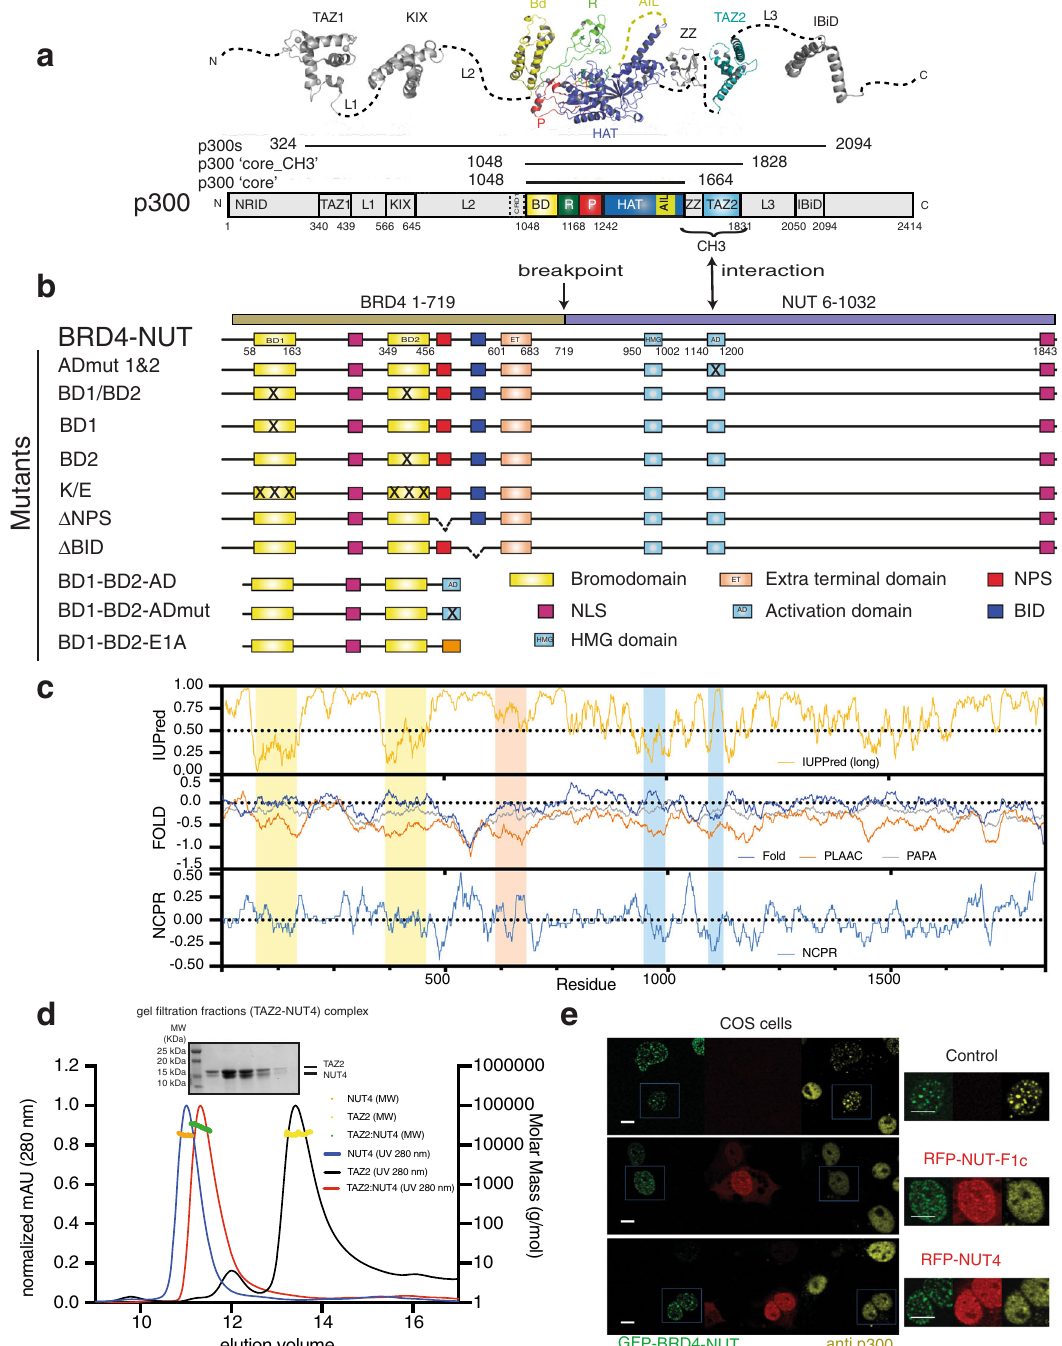
Fig. 1 | Identi fi cation of anacidic activationdomain in NUT. a Domain structure of p300 and b BRD4-NUT constructs. c IUPred, prediction of intrinsic disorder; FOLD,foldingpredictionusingthefoldindex(blue),PLAAC(Prion-LikeAminoAcid Composition; orange) and PAPA (Prion Aggregation Prediction Algorithm; grey) analysis, NCPR (Net Charge Per Residue) with a sliding window of ten residues of the BRD4-NUT protein. d SEC-MALLS analysis of the TAZ2 domain of p300 alone (black), NUT4 alone (blue) and the complex between TAZ2 and NUT4 (red). SDS-